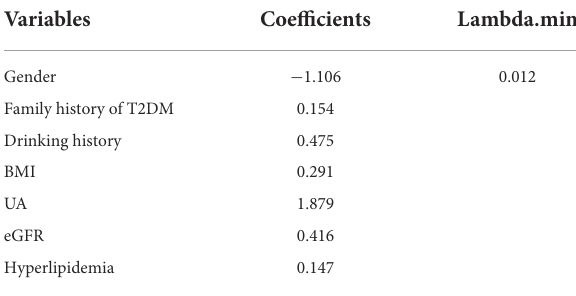
TABLE 3 Coefficients and lambda.min value of the LASSO